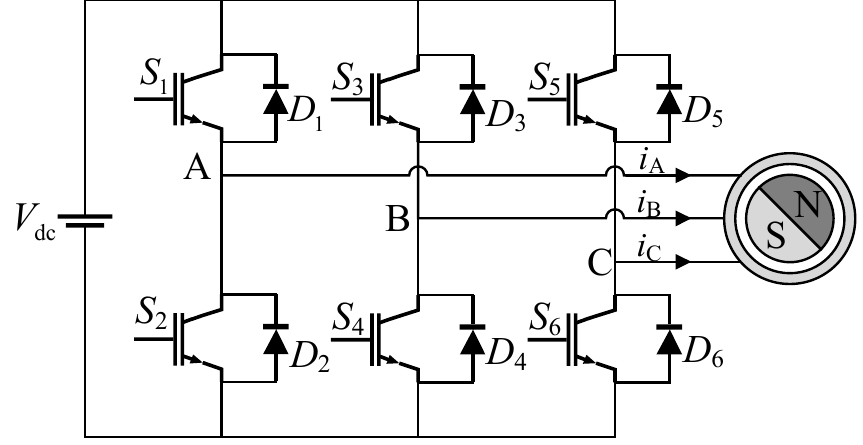
Figure 2. PMSM with three-phase pulse-width modulated voltage-source inverter (PWM VSI).